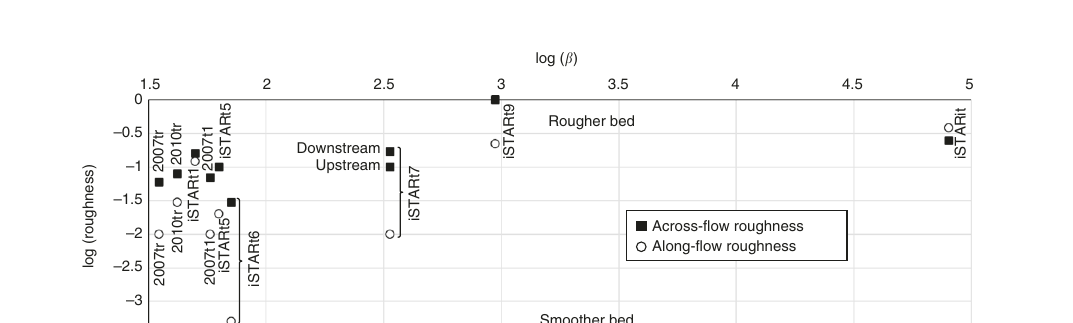
FFT fast Fourier transform τ b and U b are the mean basal shear stress (kPa) and mean basal ice velocity (ma − 1 ) from model inversion 37 ; P r is the measured upstream propagation rate of ice thinning per ice-stream tributary from 1992 to 2015 using a thinning/non-thinning threshold of 1.0ma − 1 6 and β is the inverted basal traction coef fi cient equal to τ b / U b . Columns 6 and 7, respectively, list the dominant vertical heights (measuredtrough-to-crest)andtypicalwidths ofstreamlinedfeatures;inthecasesofpatchesiSTARt5,iSTARt7andiSTARt9,twosetsarelisted,wherethesmallervaluespertaintolikelyMSGLandthe larger values pertain to the longer-wavelength lineations over which the MSGL are superimposed. Most lineations continue beyond the patch boundaries rendering us unable to provide typical lengths. Columns 8 and 9 list normalised FFT-derived roughness values retrieved from pro fi les taken across and along fl ow, respectively, using 2-km moving windows — see Methods summary for more details. For iSTARt7, two across- fl ow pro fi les were measured, one across the relatively fl at upstream region and one across the higher elevation, rougher downstream portion